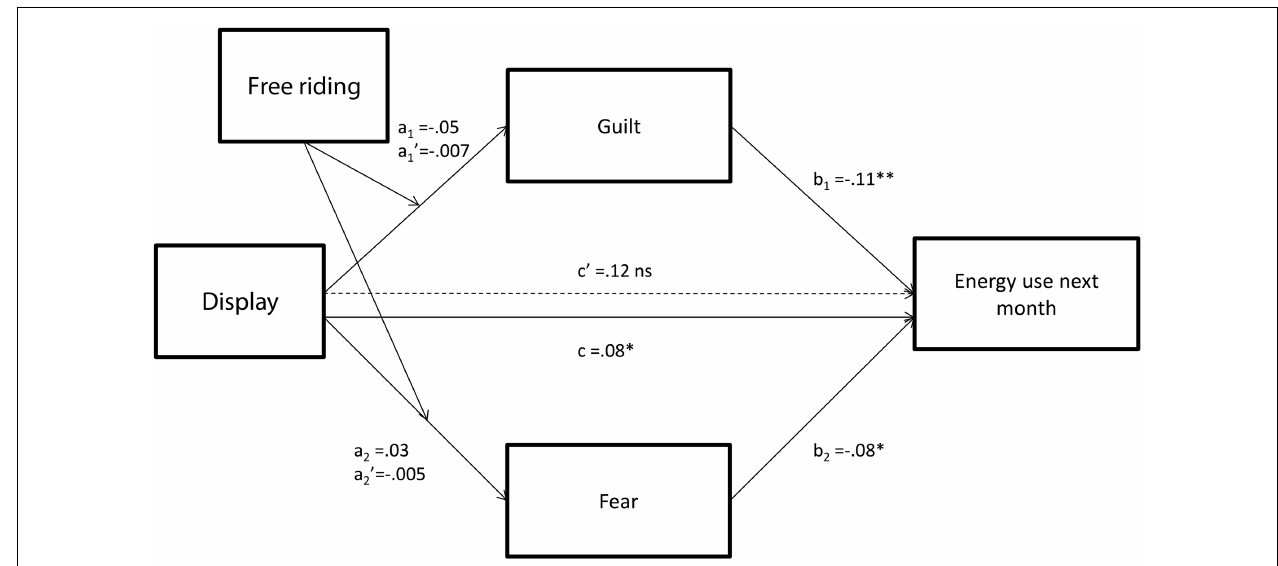
there is a free-rider, a (cid:48) and a (cid:48) , its effects in the control condition. b 1 and b 2 1 2 represent the direct effects of emotions on the amount of energy people want to use the following month, and c and c (cid:48) , respectively the direct effects and residual effects of the type of display on energy use intention the following month. * p < 0.05, ** p <